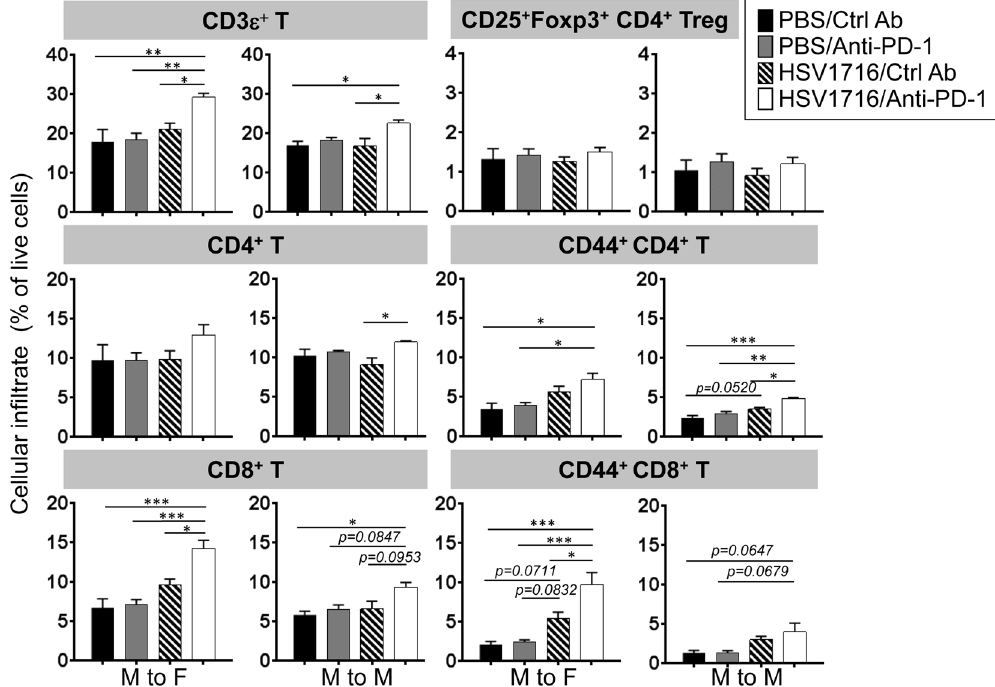
Figure 6. The splenic population of CD8 + T cells increases following combination therapy and varies with tumor immunogenicity. Female (M to F) or male (M to M) M3-9-M tumor-bearing mice received three doses of intratumoral HSV1716 injection followed by intraperitoneal injection of anti-PD-1 or control antibody as shown in Fig. 4a. Immune cell infiltrates in spleens were evaluated by flow cytometry analyses 72 hours after last dose of HSV1716 injection. Data show mean and SEM (n = 3~6 per treatment group). Statistical analysis was performed by a one-way ANOVA with Tukey-adjusted post hoc tests ( * p < 0.05, ** p < 0.01 and *** p <